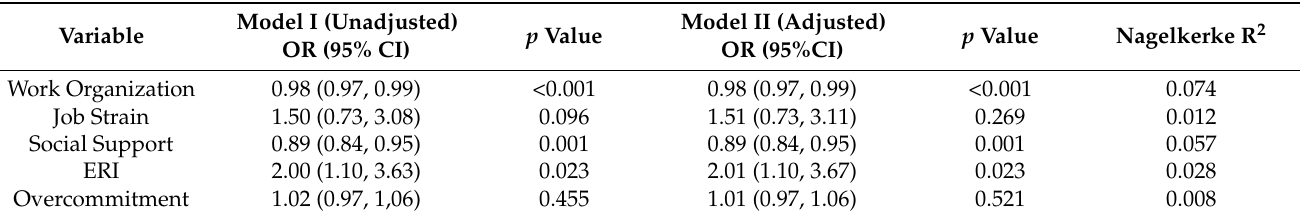
Table 7. Relationship between work organization, occupational stress, and the risk of having taken sickness absence for disorders other than musculoskeletal